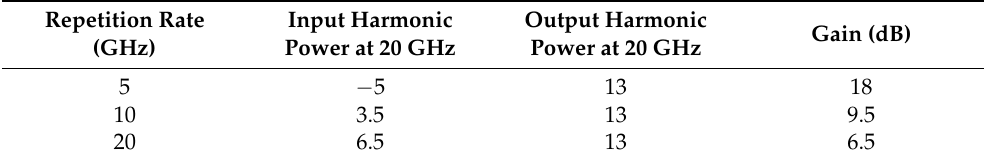
Table 3. The gain for the realistic “AND” signal practicability at the lower common harmonic frequency of 20 GHz.